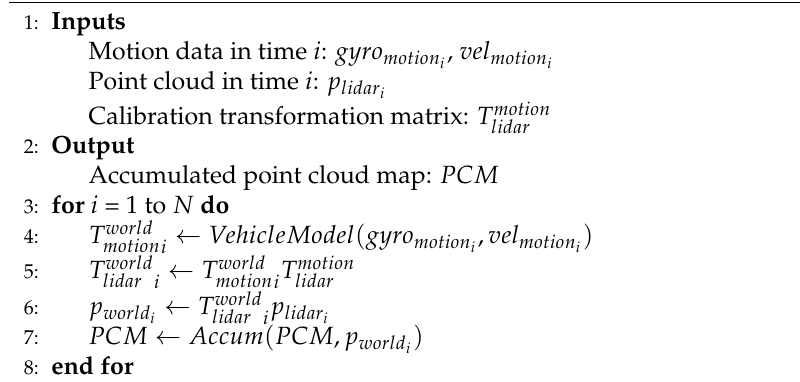
Figure 3. ( a ) Result of accumulated point cloud map (PCM) using the good calibration parameter; ( b ) result of accumulated PCM using the wrong calibration parameter. Algorithm 1 Point Cloud